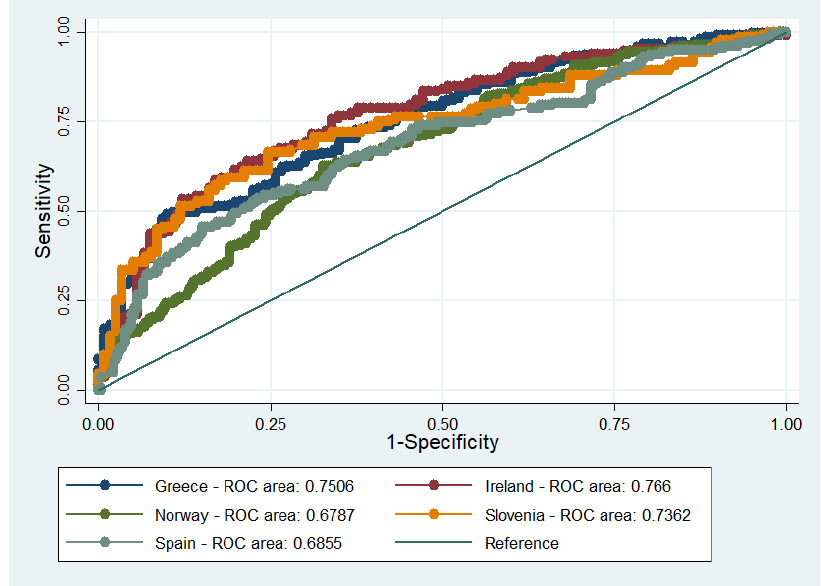
Figure 2. ROC curves and C-statistic estimates for the national models (households).